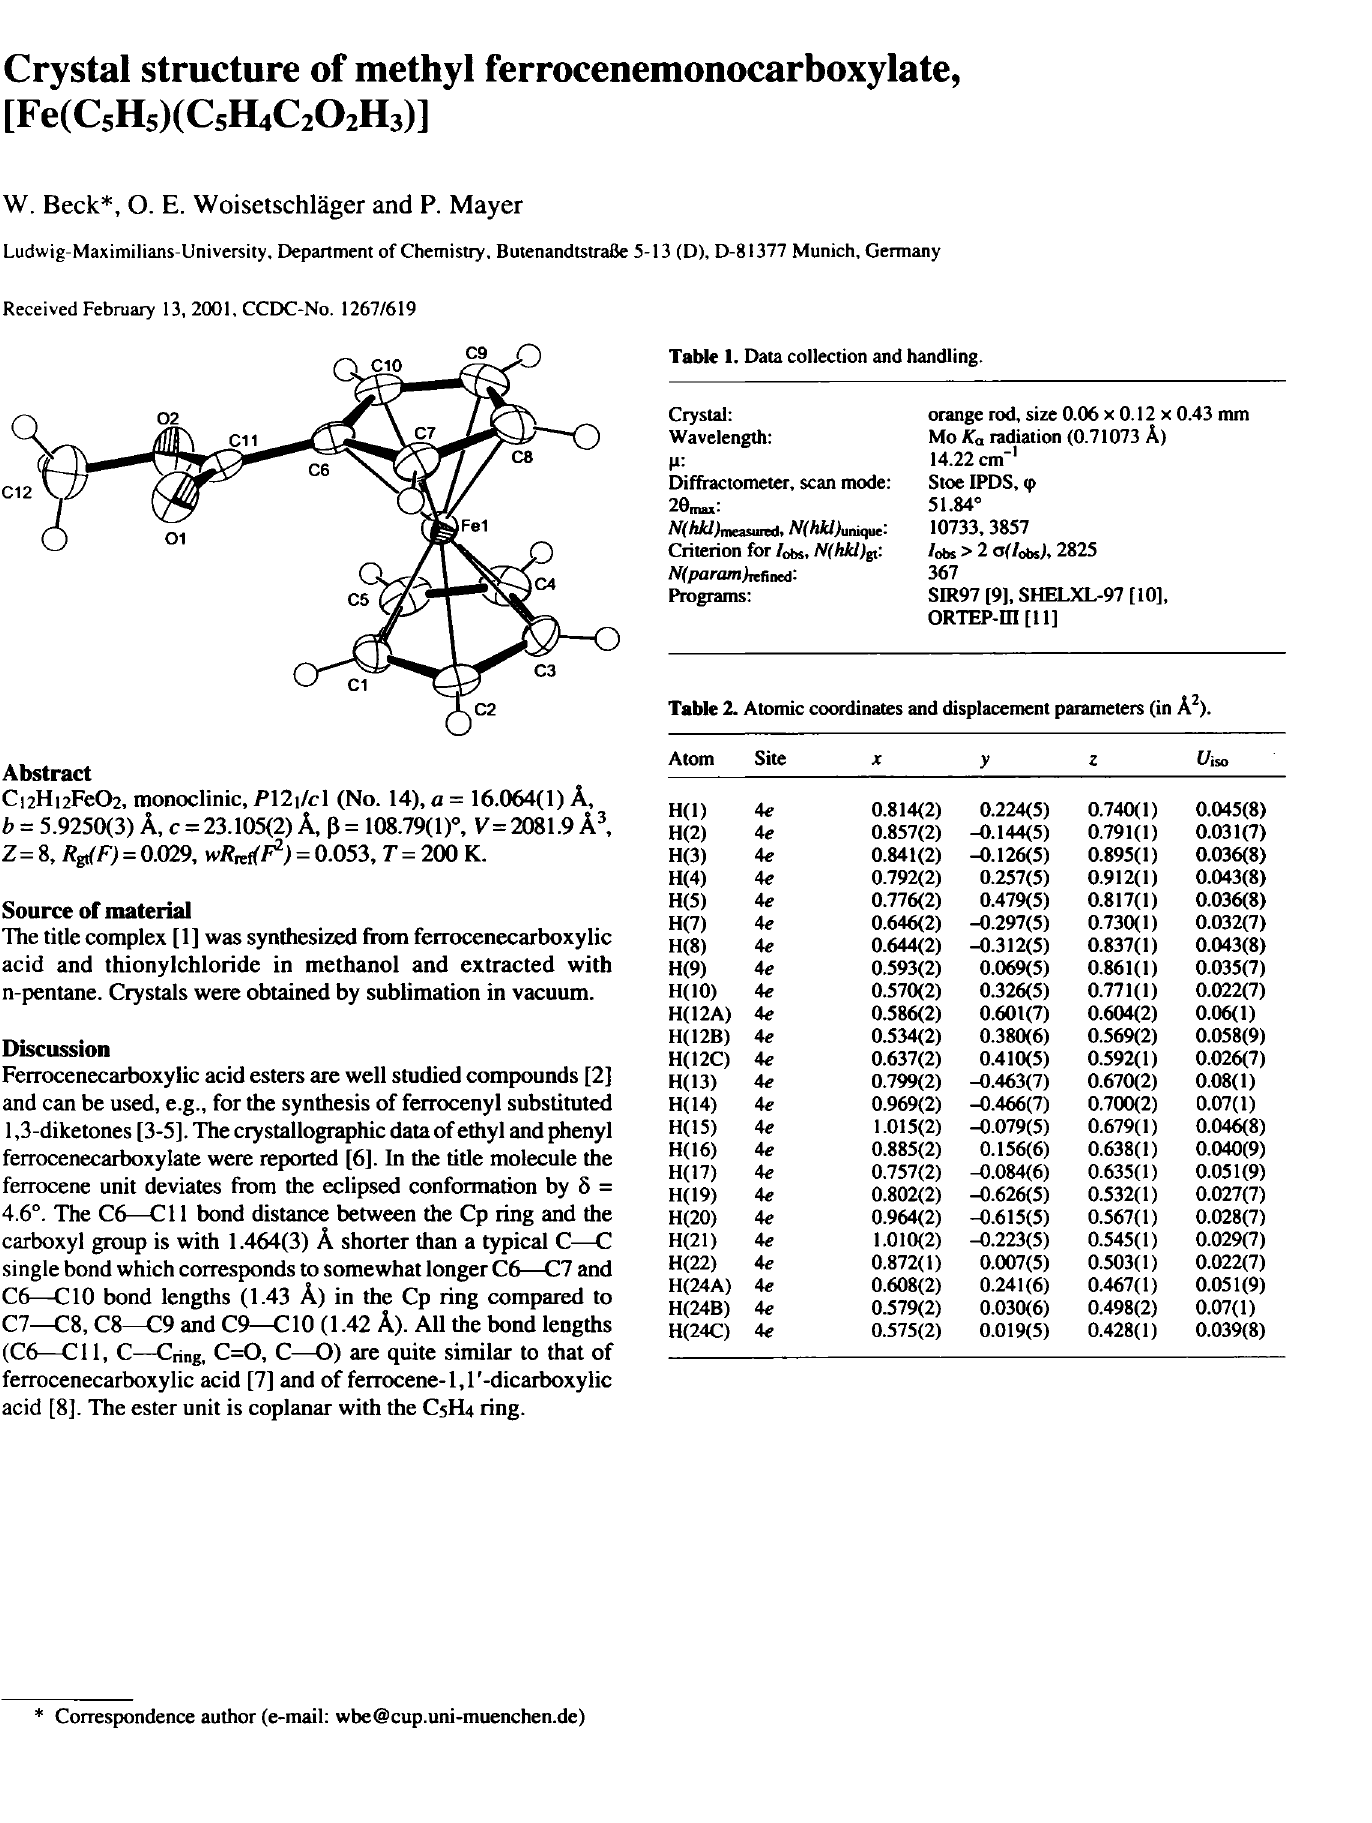
Table 1. Data collection and handling.